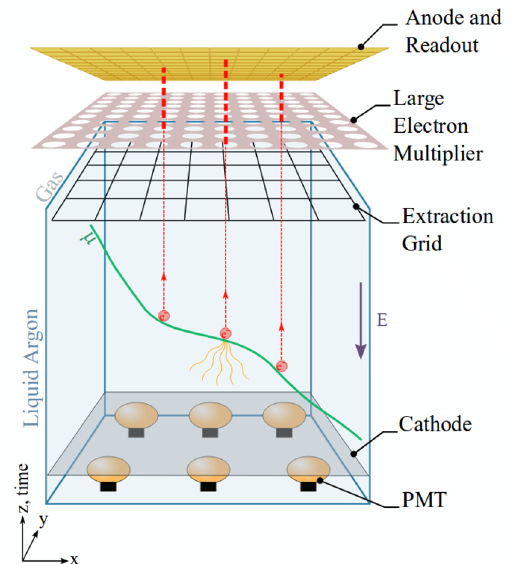
Figure 3 . Sketch of a DP LAr TPC. The scintillation light produced by charged particles is collected by photomultiplier tubes (PMTs) at the bottom of the detector while the ionization charge is drifted upwards and amplified in argon gas before it is collected by two perpendicular readout